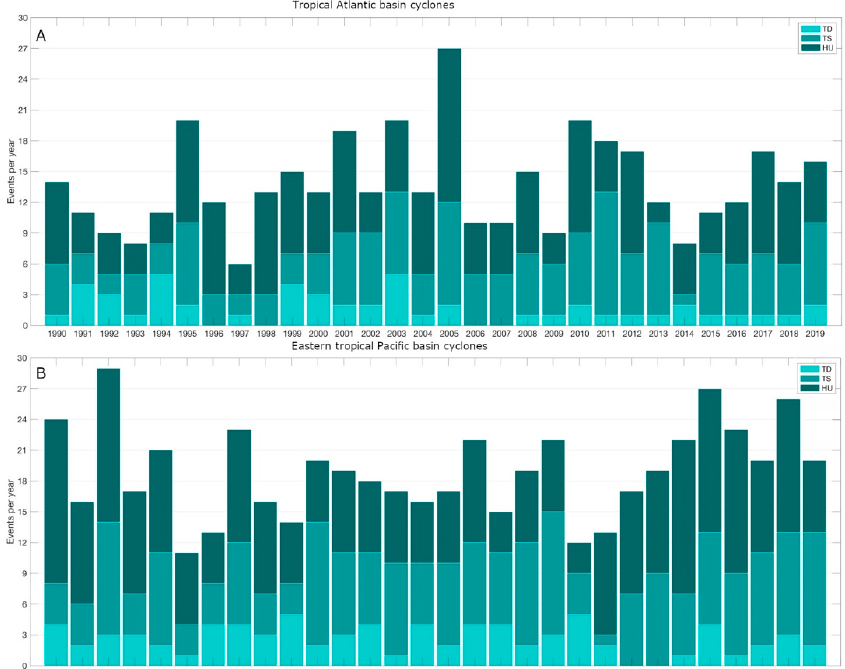
Figure 5. Annual distribution of TCs in the ( A ) Atlantic and ( B ) eastern tropical Pacific based on the historical HURricane DATa 2nd generation(HURDAT2) record available at the National Hurricane Center (NHC) (http://www.nhc.noaa.gov) for the 1990–2019 period. The occurrence of hurricanes affecting the Central American coast features a large number of severe events hitting the Caribbean coast. This demonstrates the indirect and direct relevance of these systems.